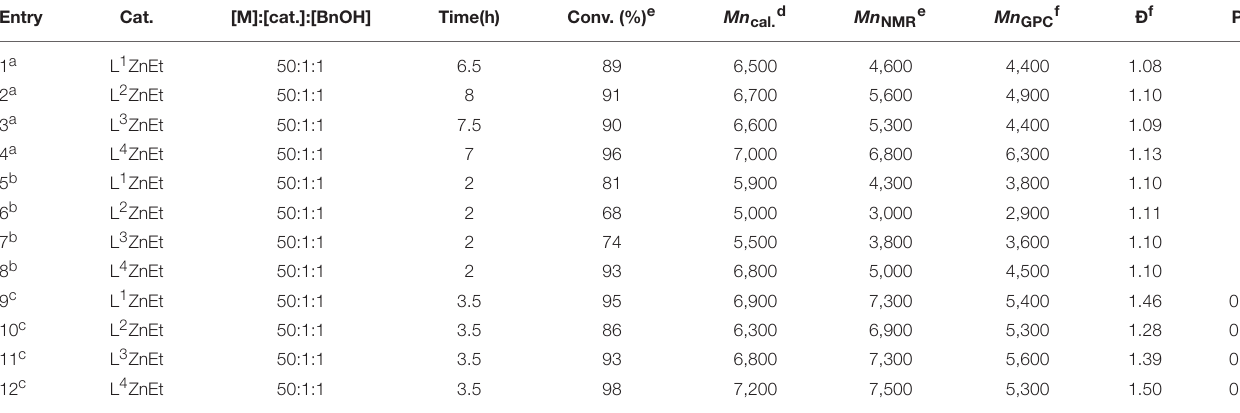
TABLE 1 | Rinrg opening polymerizations of L -LA and rac -LA by Zn